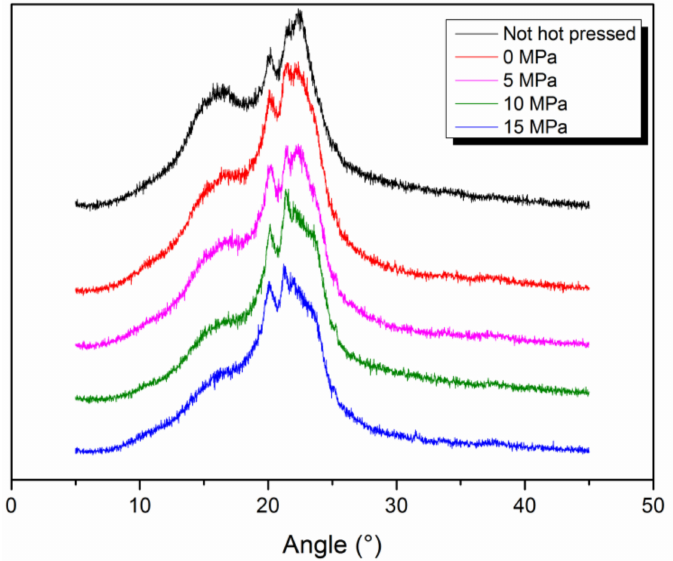
Figure 5. X-ray diffraction (XRD) curve of composite HBM under different pressures in hot